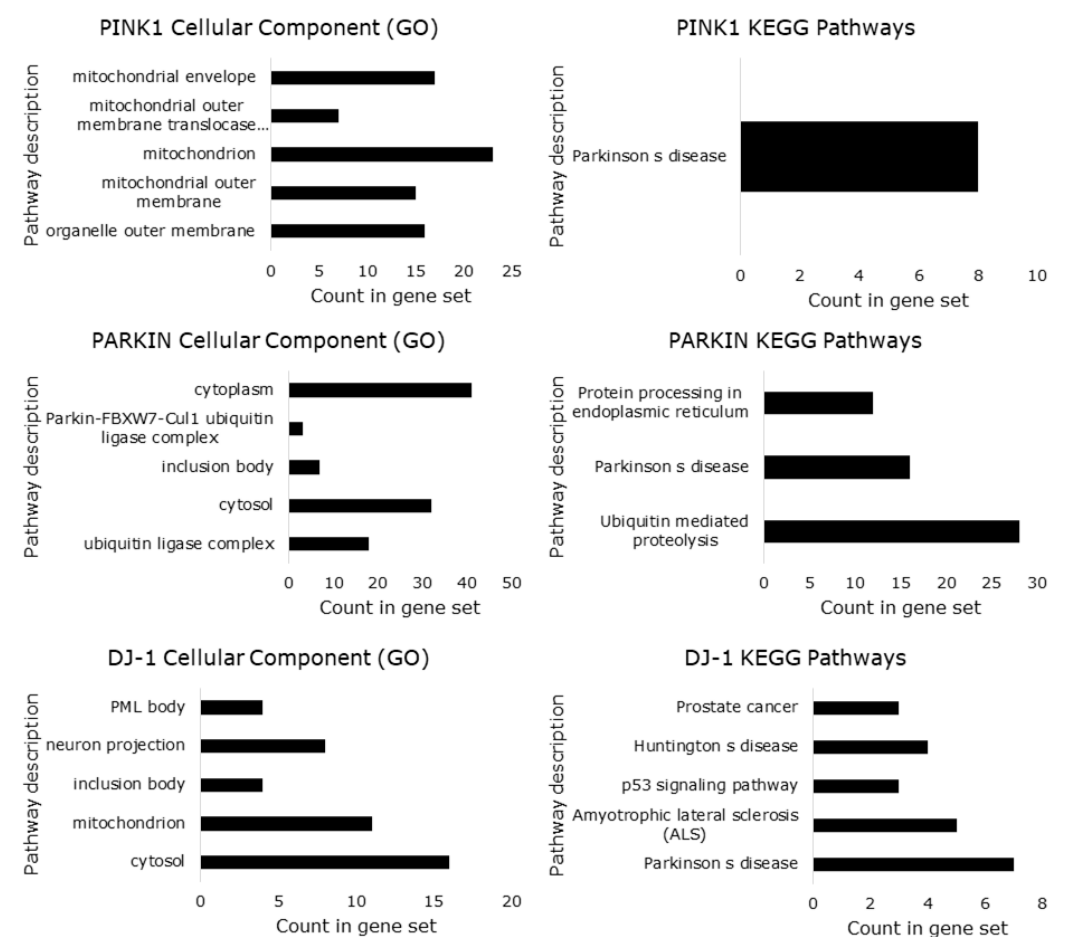
Figure 7. Gene ontology enrichment analysis for cellular component and KEGG pathways in the interaction networks of PINK1, PARKIN, and DJ-1. The numbers on the horizontal axis represent the enrichment score. A high enrichment score related to the genes were found more frequently in the ontology.